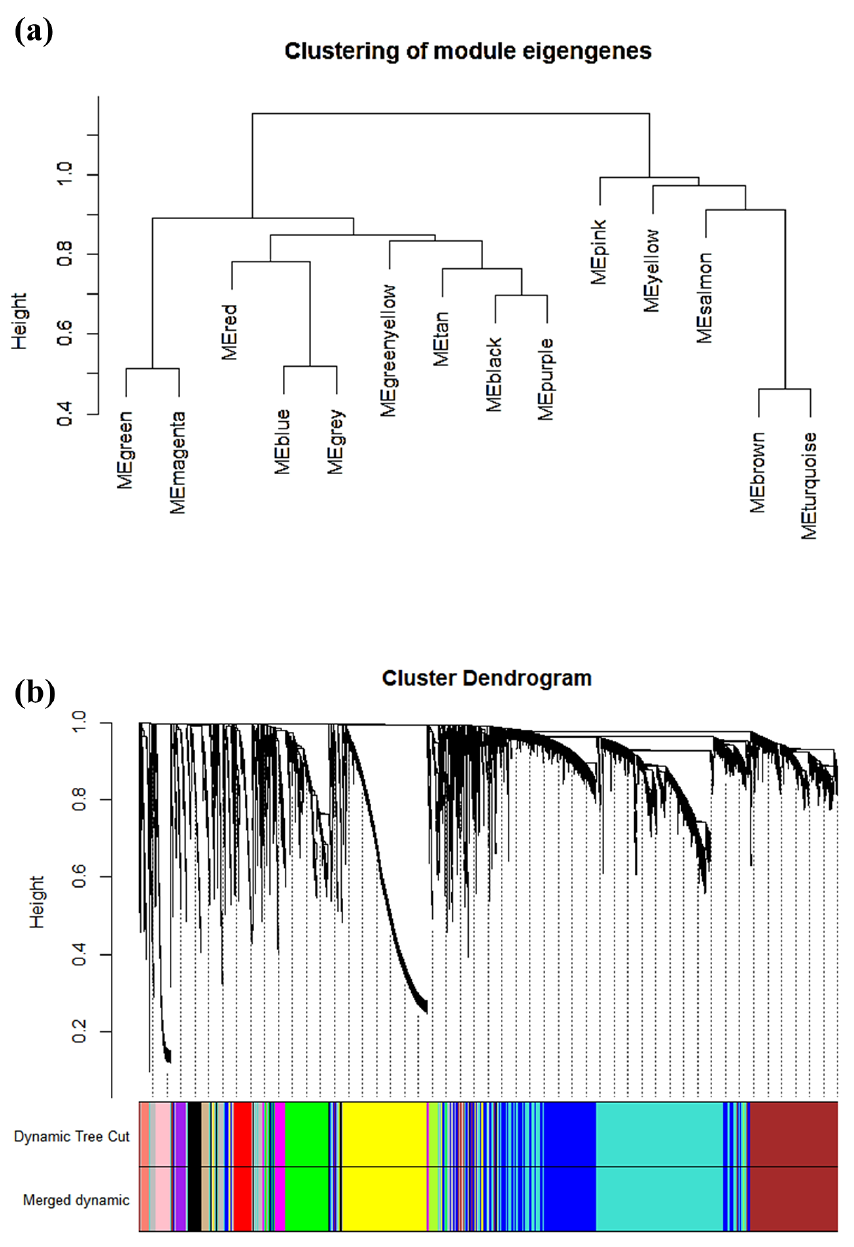
Figure 4. Module clustering results by WGCNA. ( a ) Dendrogram of dissimilarity between modules. ( b ) Gene dendrogram based on dissimilar (1-TOM) clustering. Each branch of the tree diagram represents a gene.